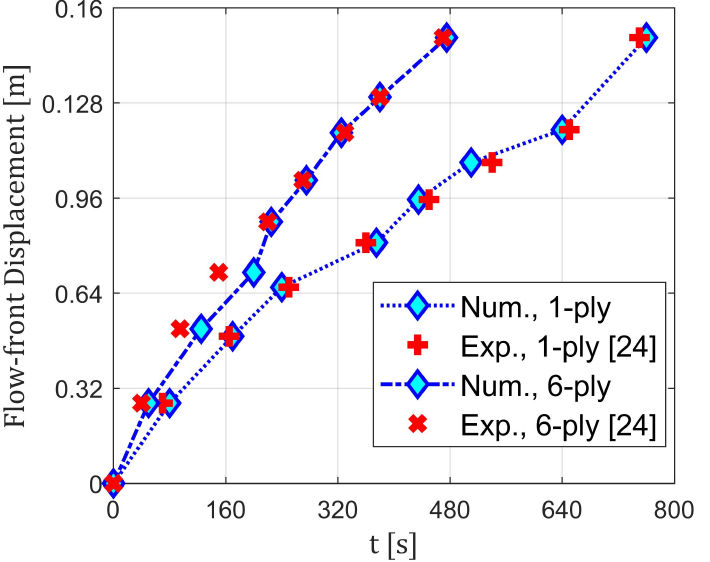
Figure 8. Numerical flow-front predictions vs. experimental observations for a complex shape with single and multiple plies.